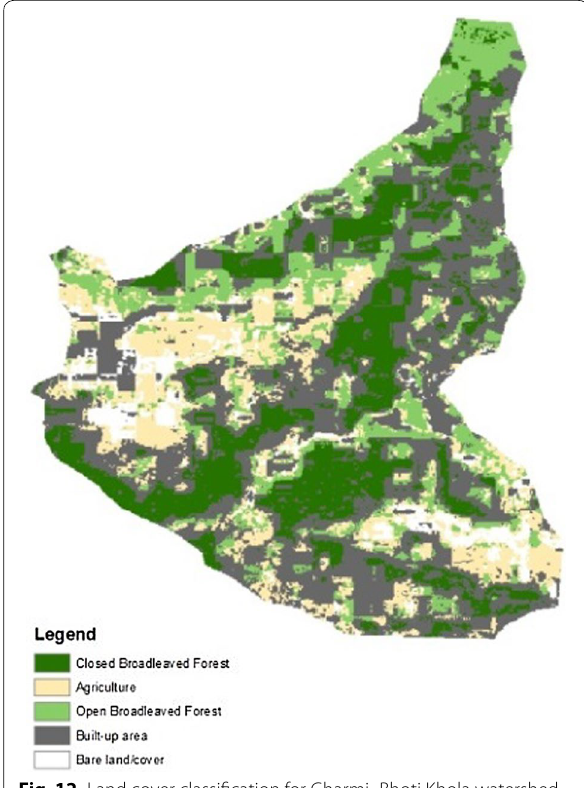
Fig. 12 Land cover classification for Gharmi–Bhoti Khola watershed